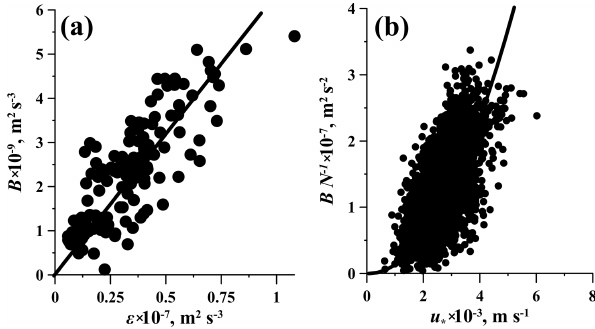
Figure 12. Buoyancy flux at the ice–water interface B as a function of (a) TKE dissipation rate ε and (b) friction velocity u ∗ .